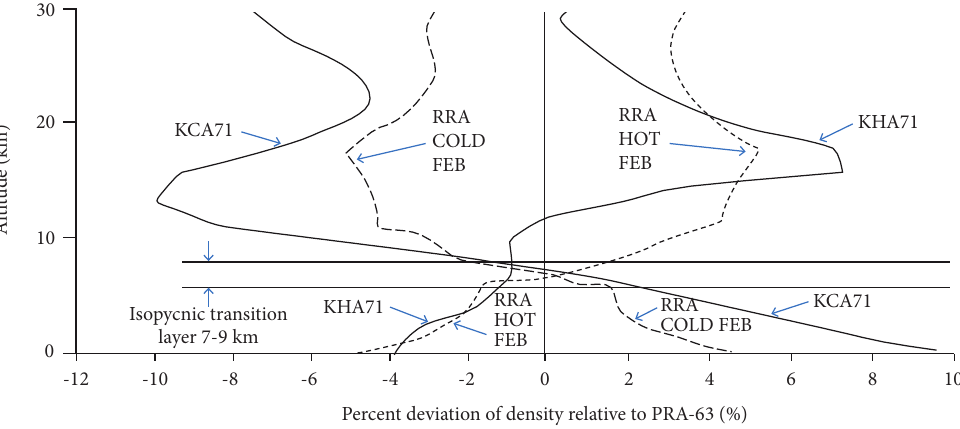
Figure 2. Atmospheric density dispersions of KSC hot (KHA-71) and cold (KCA-71) extreme atmospheres, and RRA dispersion models for February, all relative to the annual Patrick Reference Atmosphere 1963 (PRA-63) (Smith-Weidner